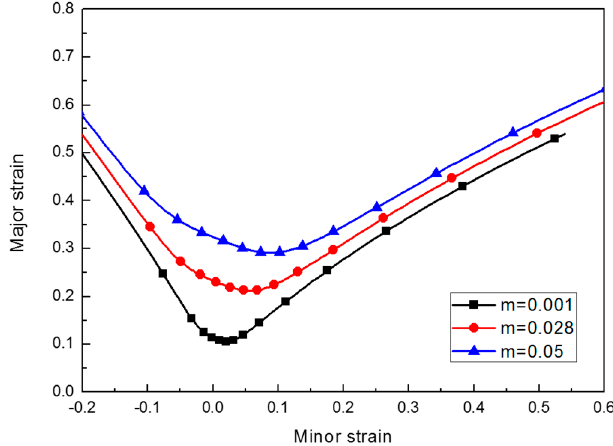
Figure 13. Theoretical forming limit diagram of Al 6061-T6 material.